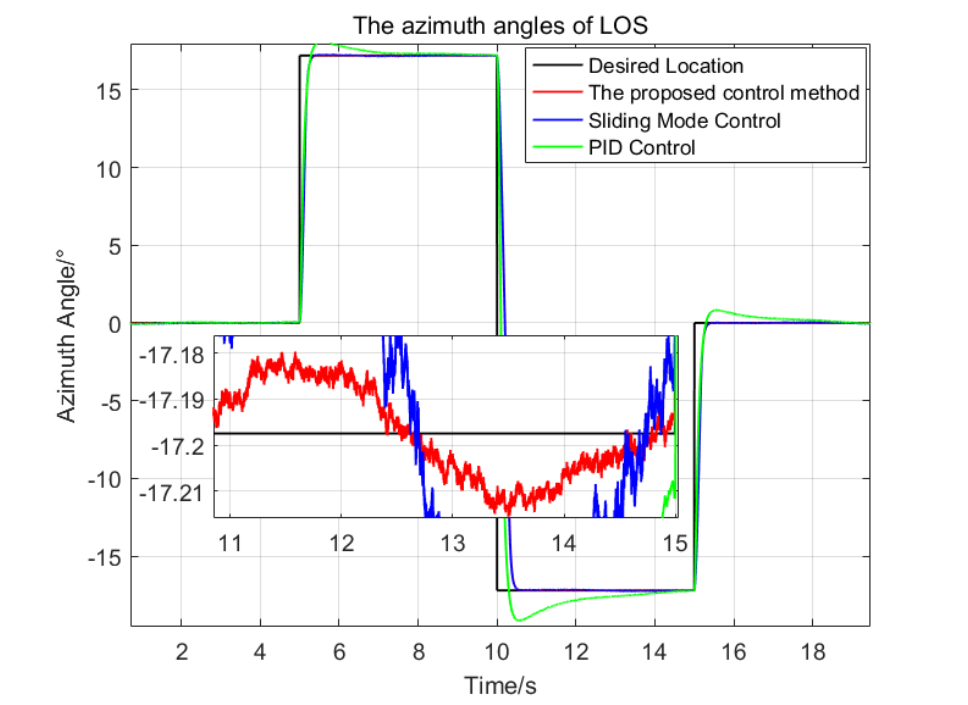
Figure 7. The comparison of the azimuth angles of the LOS generated by the three control methods. The settling time of the proposed control method is about 0.6 s. The maximum deviation from the desired pitch angles is 0.021 ◦ , which is 21.2% of the SMC and 0.4% of the PID respectively; The maximum deviation from the desired azimuth angle is 0.019 ◦ , which is 32% of the SMC and 1.0% of the PID,